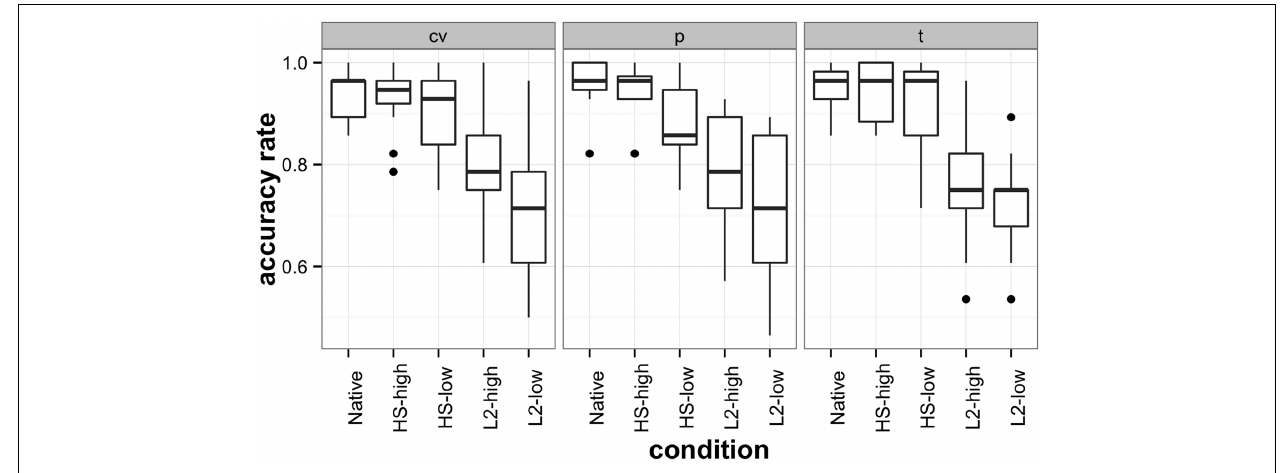
FIGURE 3 |AXB discrimination task accuracy scores across all groups. The labels ‘cv’, ‘p’, and ‘t’ represent the three critical conditions, the C’VC-CjVC, final /p–p’/, and /t–t’/ consonants.